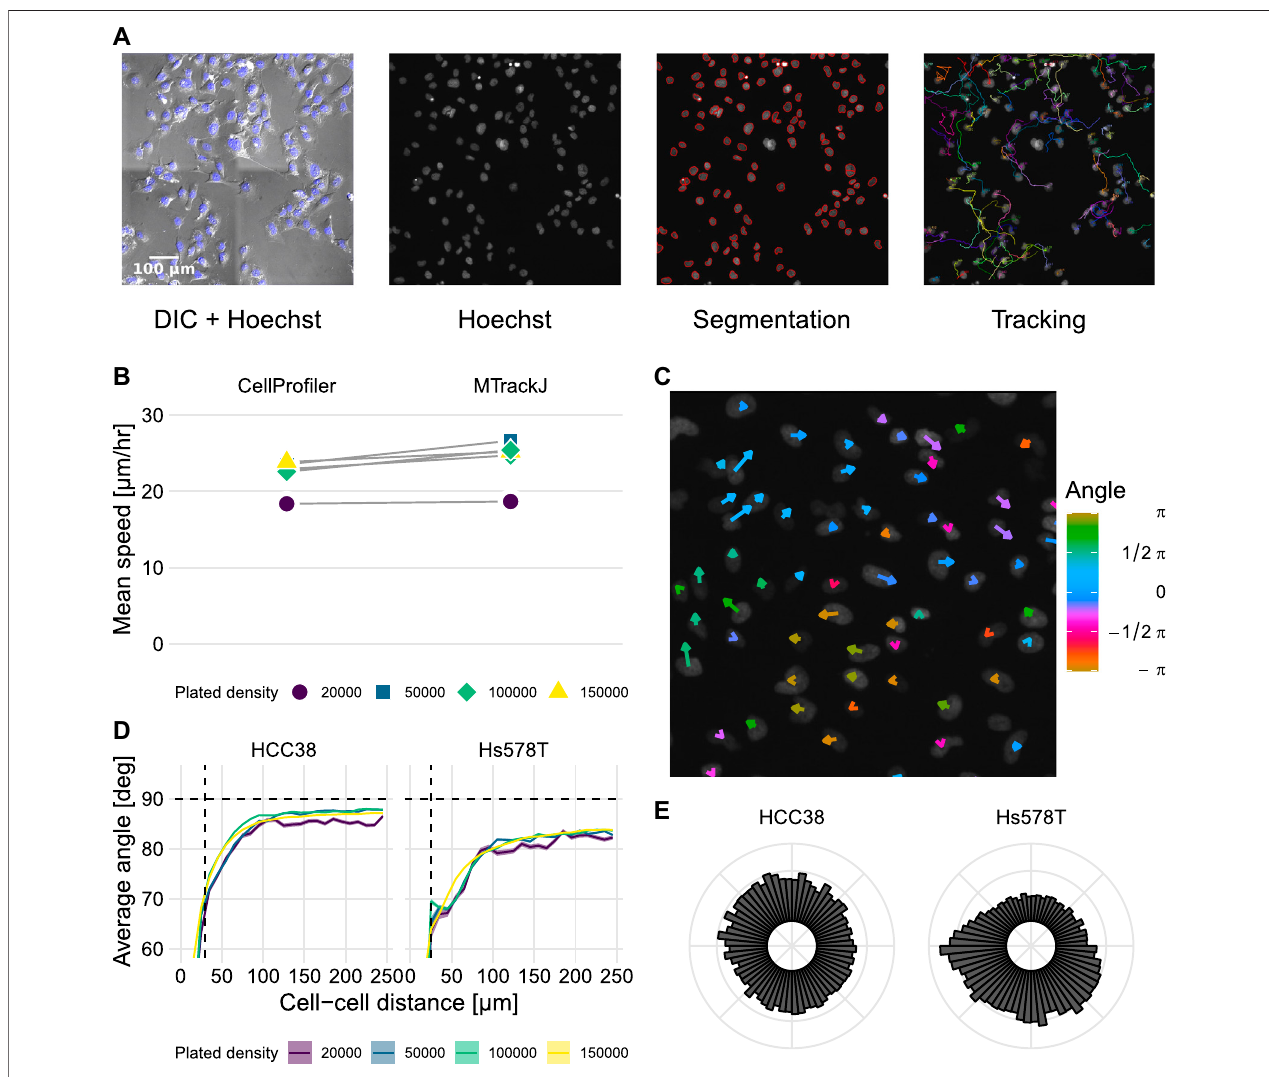
FIGURE 1 | Identi fi cation of streams in automatically tracked videos of HCC38 and Hs578T. (A) Experimental setup and tracking work fl ow: nuclei were segmented using Hoechst,afterwhich theyweretracked.ImagesshowHCC38cellsat50,000cellsper well(frame50outof71frames). (B) Measured speed fromautomated tracking usingCellPro fi lerandfrommanualtrackingusingMTrackJ. (C) LocalmigrationdirectionsatonetimepointinHs578Tcells.Sizeandcolorindicateinstantaneousspeed and currentdirectionofmigration.Imageisamagni fi cationofthetopleftcornerofthebottom-rightmostvideoin SupplementaryVideoS1 (Hs578T,50,000cellsperwell, frame 51/71). (D) Analysis of migration angles between cell pairs as a function of the shortest distance between their centers of mass, at indicated plated cell densities. Horizontal dashed lines show theoretically expected average angle for random migration, vertical dashed lines show approximate nuclei diameter. (E) Polar histogram of migration directions of HCC38 and Hs578T cells. Note that “ plated density ” in (B,D) refers to the number of cells introduced into an entire well.